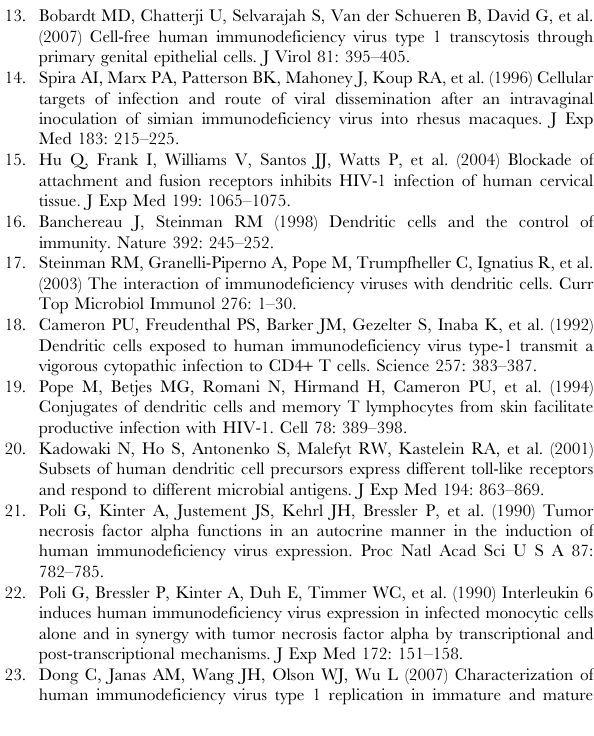
Figure S3 PPAR c and LXR ligand treatment do not prevent MDDC uptake of FITC-dextran. Immature MDDCs treated with 100 m M ciglitazone (upper panel) or 1 m M TO-901317 (lower panel) were incubated with FITC-dextran (100 m g/ml) for two hours at 37 u C and then washed extensively to remove unbound FITC-dextran. The cells were then fixed in 2% paraformaldehyde and uptake of FITC-dextran was assessed by flow cytometry. Shaded histogram, MDDCs without FITC-dextran. Blue line, untreated MDDCs. Red line, nuclear receptor ligand-treated MDDCs. Found at: doi:10.1371/journal.ppat.1000981.s003 (0.32 MB